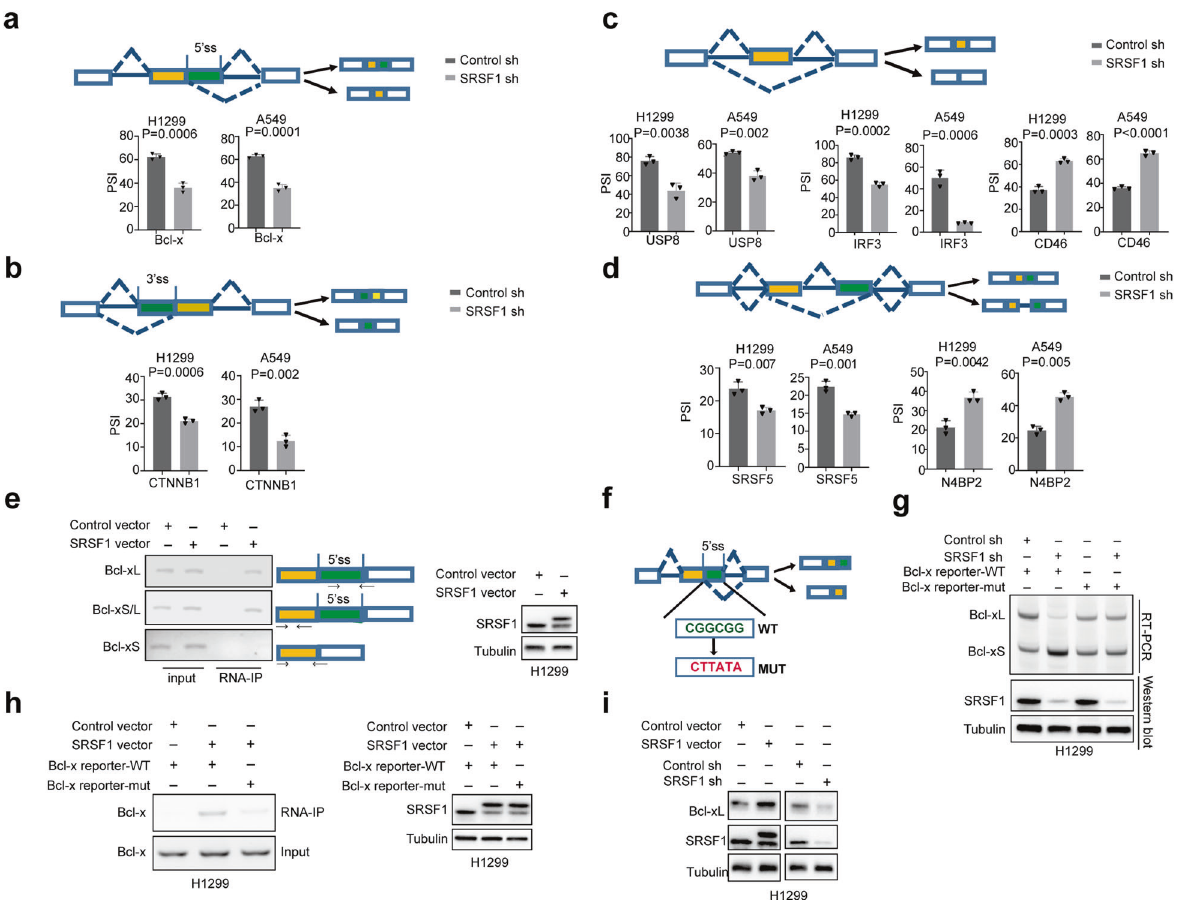
Fig. 2 SRSF1 controls Bcl-x splicing by directly binding to the pre-mRNAs. a Alternative 5 ′ splice sites usage of Bcl-x was examined in H1299 and A549 cells with stably reduced SRSF1 or control. b Alternative 3 ′ splice sites usage of CTNNB1 was determined in H1299 and A549 cells with stable knockdown of SRSF1 or control. c Exon skipping in USP8, IRF3, and CD46 were measured in H1299 and A549 cells with stable decrease of SRSF1 or control. d Intron retention in SRSF5, and N4BP2 were investigated in H1299 and A549 cells with stable reduction of SRSF1 or control. The mean ± SD of PSIs from three experiments were plotted, p values were calculated by paired Student ’ s t -test in a – d . e Binding of Bcl-x pre-mRNAs with SRSF1 was examined by RNA-immunoprecipitation assay in H1299 cells exogenously expressed FLAG- SRSF1 or control vector. Three pairs primers were used to examine Bcl-xL, Bcl-xS/L, or Bcl-xS, respectively as shown. The protein levels of SRSF1 were measured with western blot. f The schematic of Bcl-x splicing reporters with the predicted SRSF1-binding site in green and the mutated site in red. g Bcl-x splicing reporters containing wild-type or mutated potential SRSF1-binding site were expressed in H1299 cells with stable knockdown of SRSF or control to examine the splicing change of Bcl-x. The protein levels of SRSF1 were also measured. Representative gel and blots were shown. h H1299 cells were co-transfected with Flag-SRSF1 or control vector and the wild-type or mutant Bcl-x reporters, and subsequently immunoprecipitated with anti-Flag antibody. The co-precipitated RNAs were utilized to examine the level of Bcl-x by RT-PCR. A representative gel was demonstrated. The protein levels of SRSF1 were examined with western blot. i The protein levels of Bcl-xL, and SRSF1 were examined in H1299 cells with stable overexpression of SRSF or control vector and stable reduction of SRSF1 or control in a